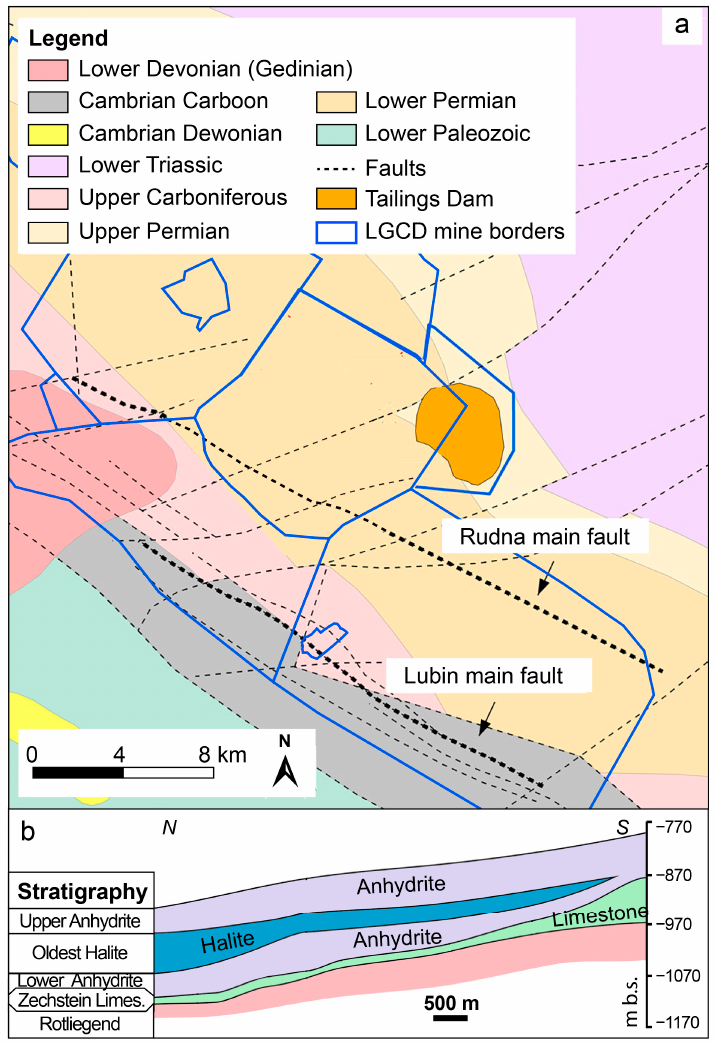
Figure 2. Geological setting of the study area; ( a ) tectonic sketch (modified from [21]); Zechstein limestones belong to Lower and Upper Permian deposits in the legend; ( b ) schematic geological section of the Rudna Copper Mine (modified from [33]).